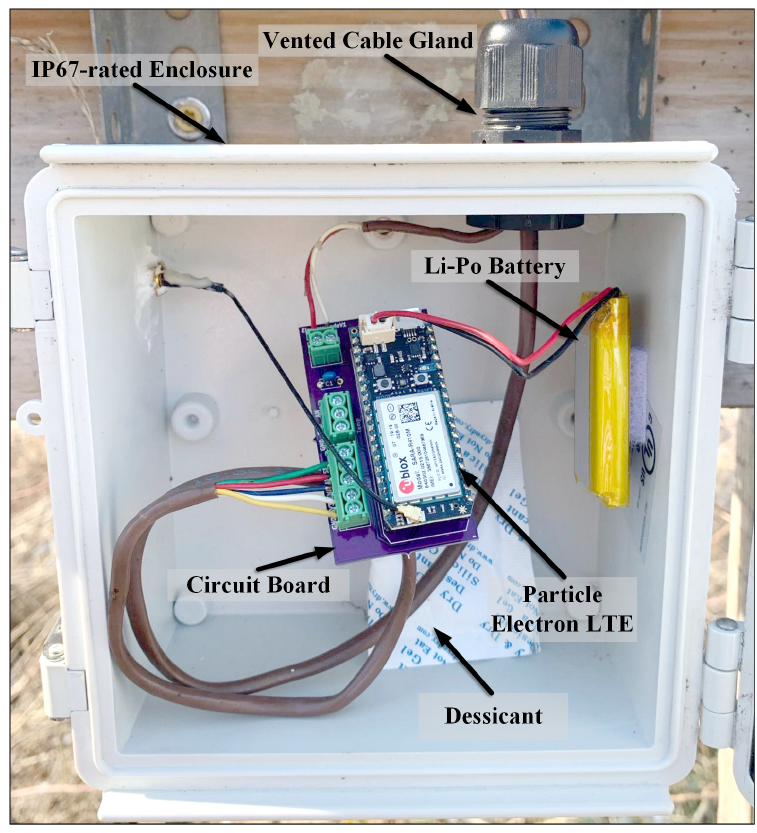
Figure 2. Components of the water level